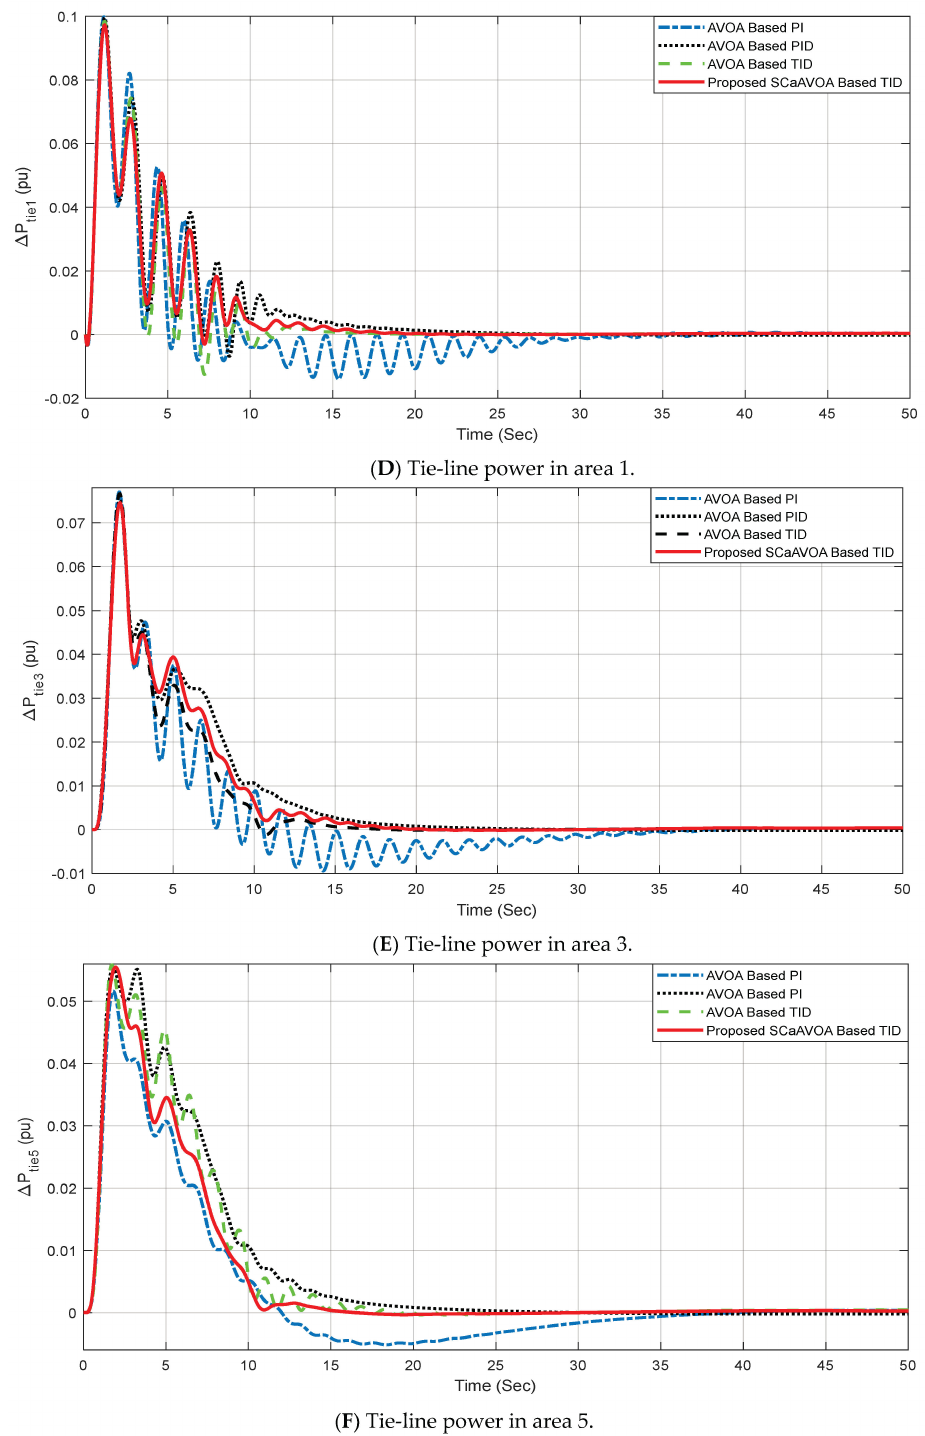
Figure 7. ( A – F ) System response for the five-area, ten-unit power system with all